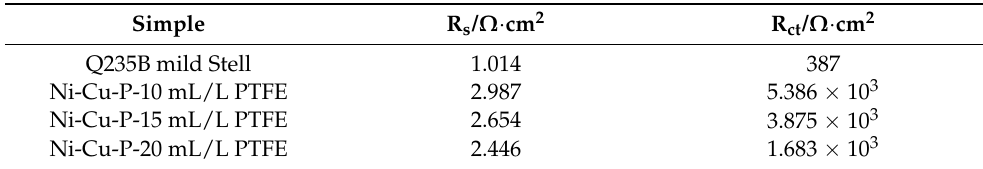
Table 3. Impedance values of the best-fit circuit for Q235B mild steel and Ni-Cu-P-PTFE composite plating with different PTFE concentrations.